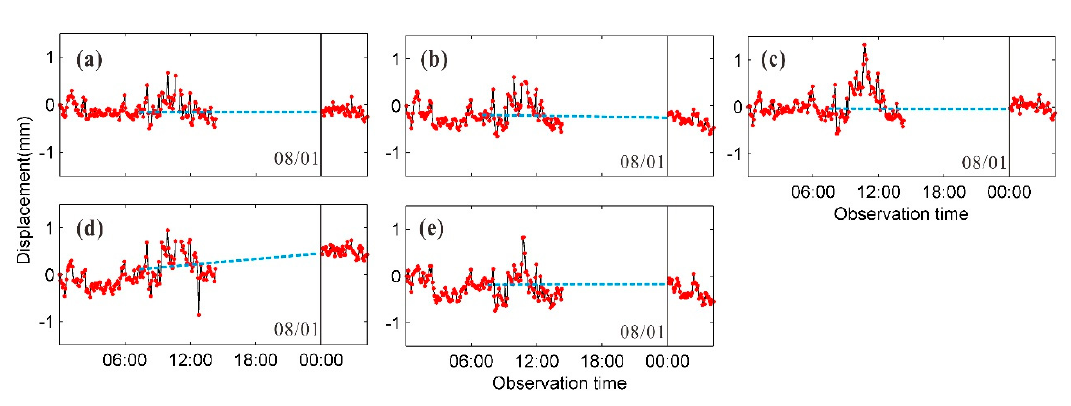
Figure 15. Connection of continuous monitoring data at five elevation positions of dam central axis using di ff erential GB-InSAR results: ( a ) 65 m ( b ) 105 m, ( c ) 122 m, ( d ) 145 m, and ( e ) 169 m.